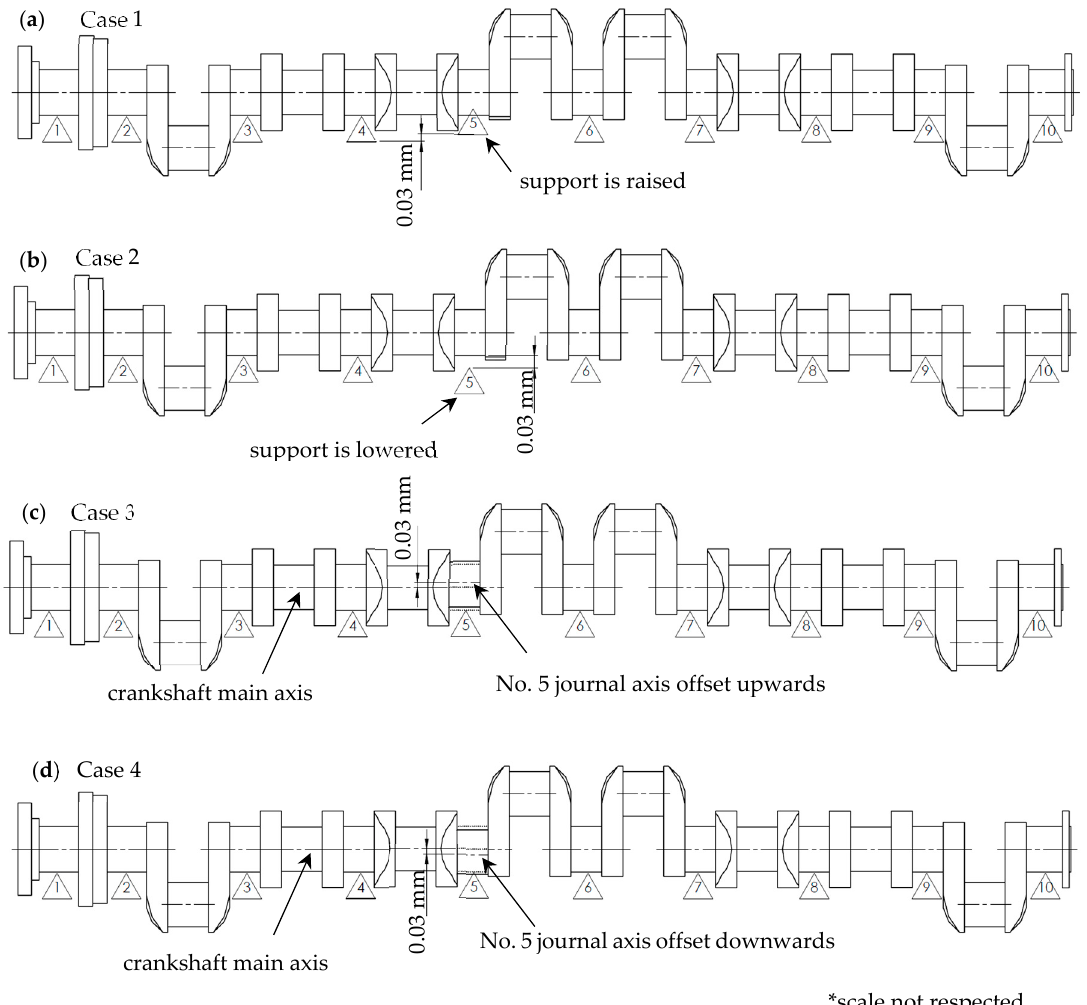
Figure 3. A graphic representation of the cases under consideration.